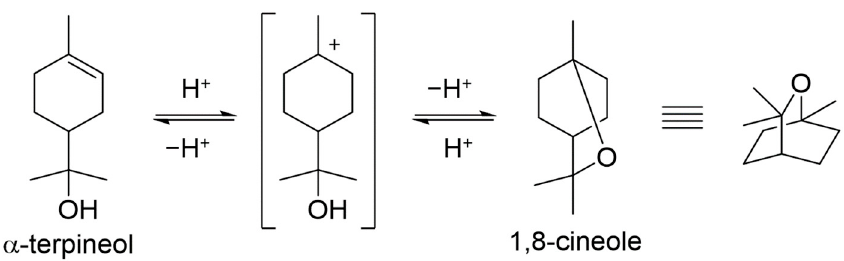
Figure 17. Isomerization of α -terpineol and